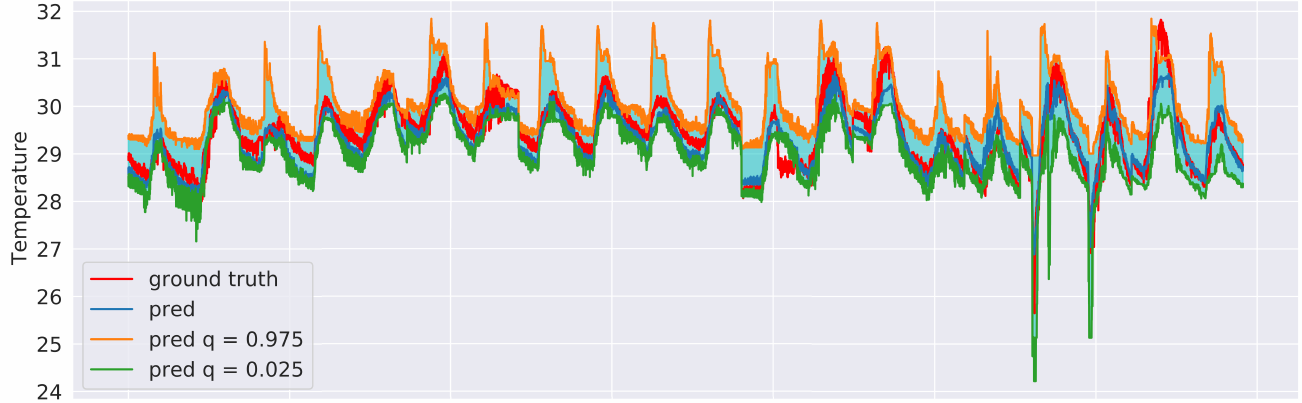
Figure 16. Gradient boosting regression prediction intervals related to sensor 3 test data with γ = 0.025 and γ =